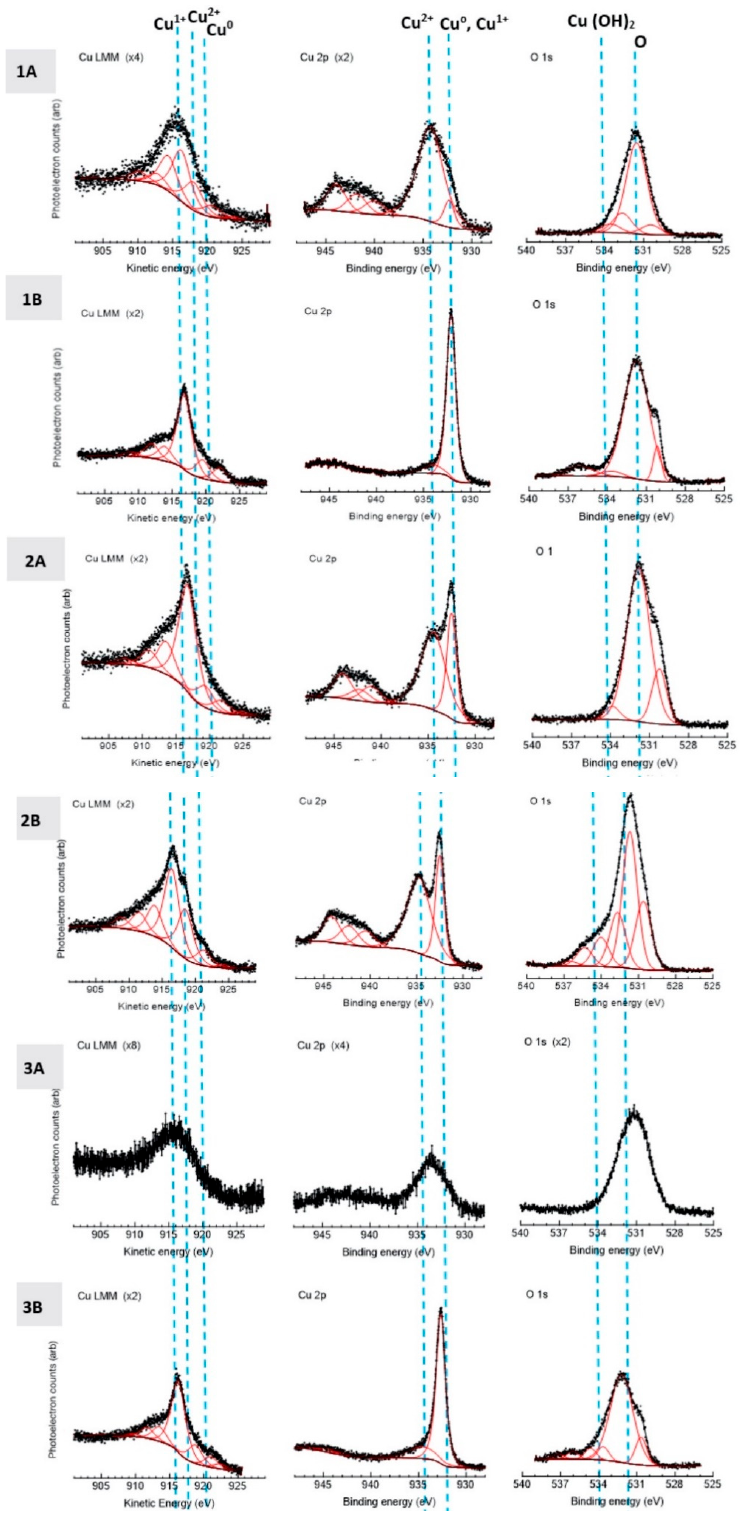
Figure29. XPSforCu, OandAugerelectronspectraintheCuLMMregion. Datafortheas-manufactured Cu cold spray coating is shown in ( 1A ) and the corroded Cu cold spray coating is shown in ( 1B ). The data for the as-manufactured nanostructured Cu cold spray coating is shown in ( 2A ). Data for the corroded nanostructured Cu cold spray coating is given in ( 2B ). The as-manufactured bulk / wrought Cu is in ( 3A ) and the corroded bulk / wrought Cu is in ( 3B ). The dashed blue lines represent the location of each Cu and O